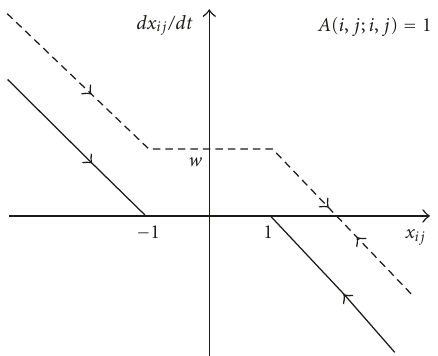
Figure 1: The DP plot of a cell. The derivative of the state value is presented in function of the state value, for w ( t ) = 0 (continuous line) and w ( t ) > 0 (dashed